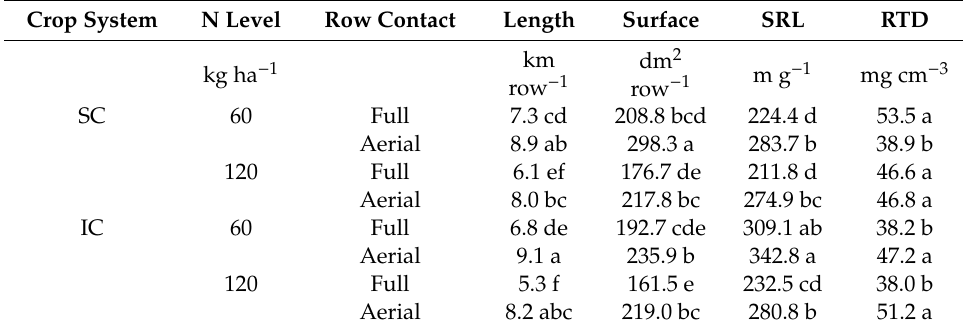
Table 7. Root parameters, Specific Root Length (SRL), and Root Tissue Density (RTD) of triticale, as a ff ected by the Crop system × N level × Row contact interaction. SC, sole crop; IC, intercrop. For each parameter, values followed by the same letter within a column are not significantly di ff erent at P < 0.05, Tukey’s